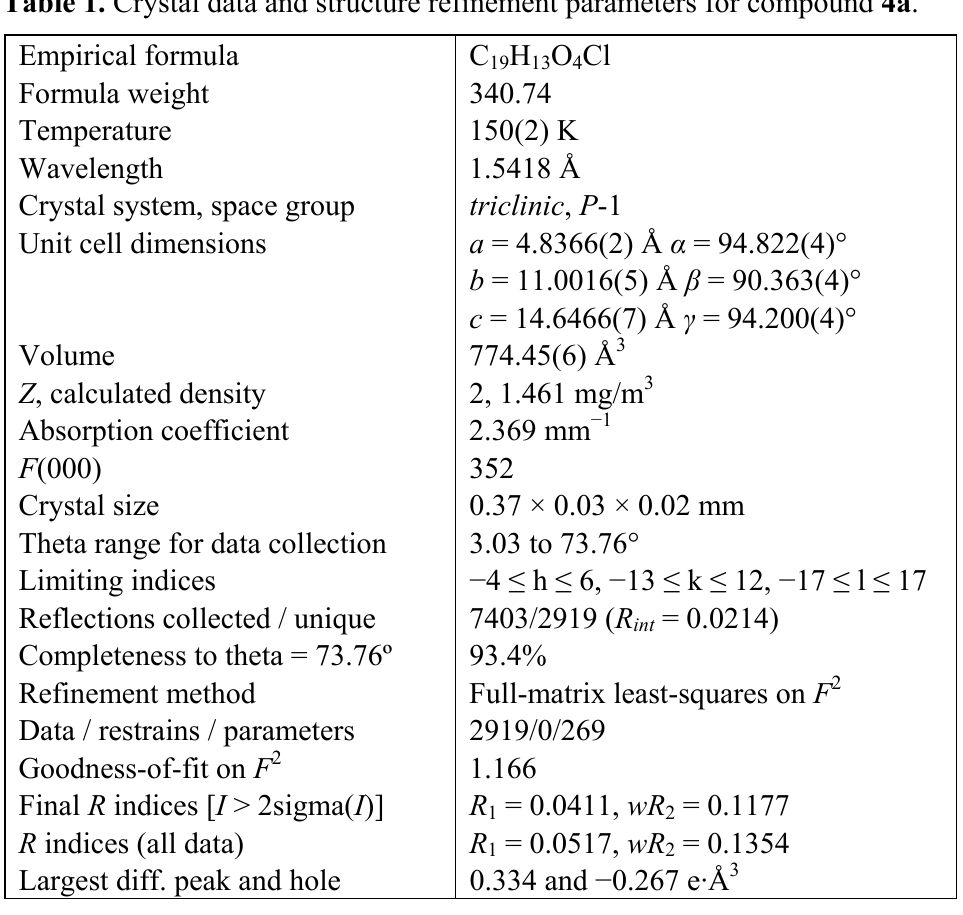
Table 1. Crystal data and structure refinement parameters for compound 4a